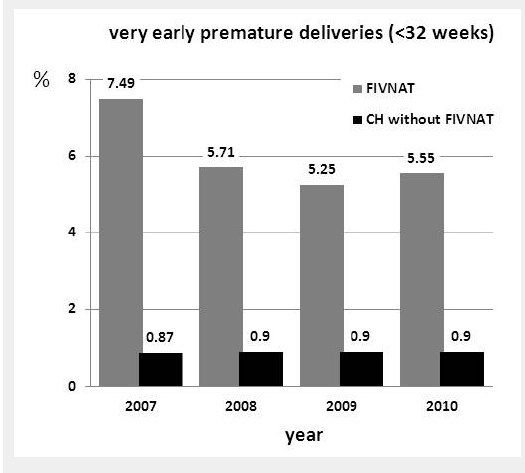
The number of treatment cycles with IVF and ICSI during freshly stimulated treatment cycles (A) and after cryopreservation and thawing (B) have been collected systematically by FIVNAT-CH since 1992 (Source: www.sgrm.org). Whereas the number of treatments with ICSI is continuously rising, those with IVF have remained stable. As the incidental total failure of fertilisation